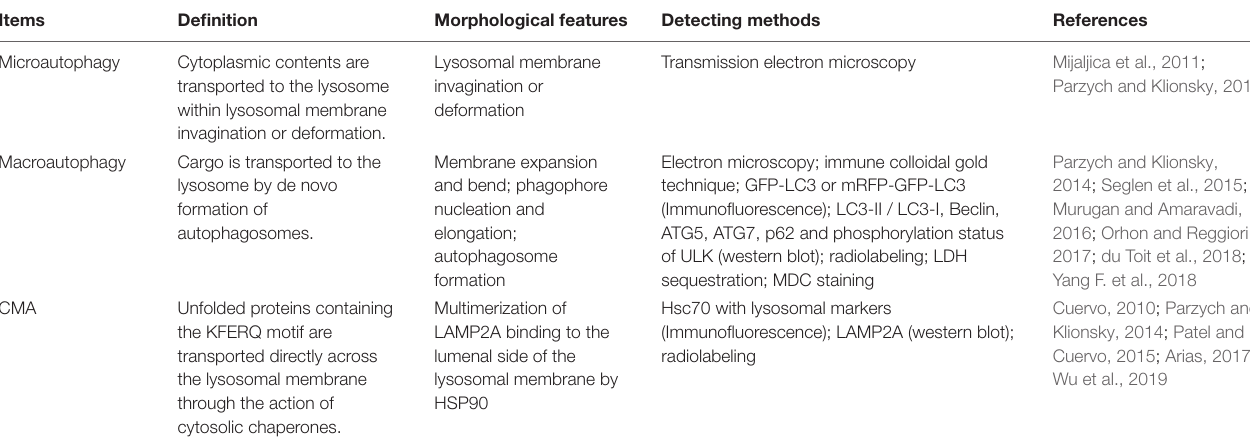
TABLE 2 | Comparison of distinguishing criteria, morphological features and monitoring methods of three kinds of